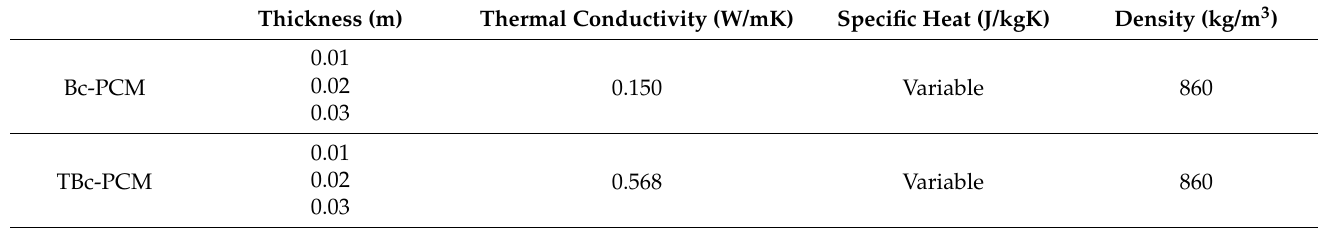
Table 3. Material properties of plain Bc-PCM and TBc-PCM.